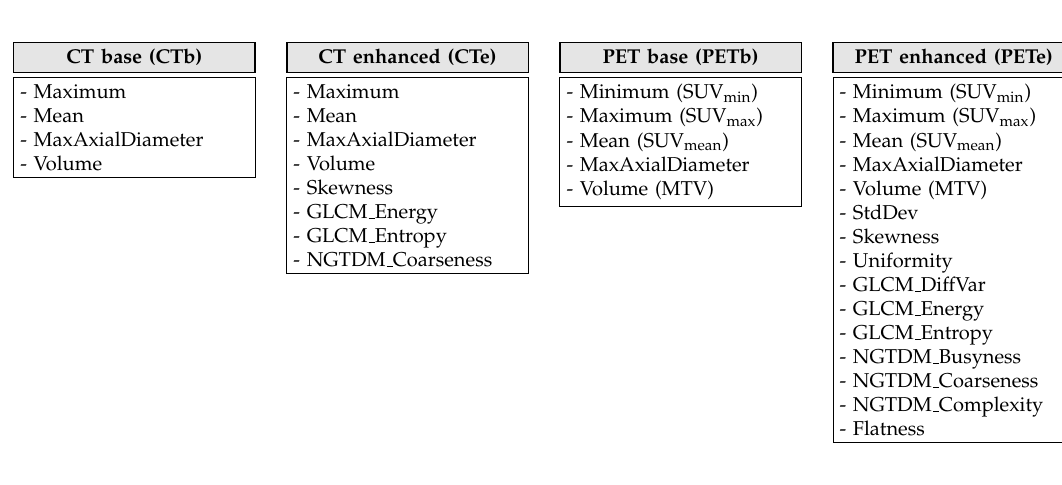
Figure 2. The four feature sets used to build the prediction